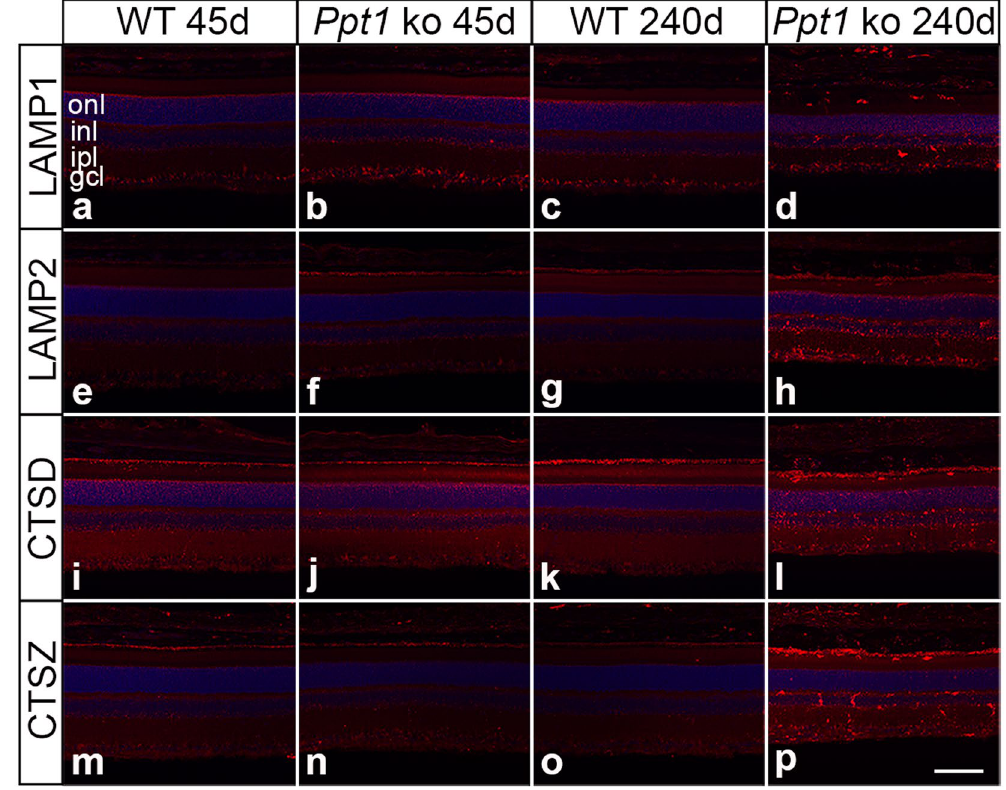
Figure 4. Dysregulation of lysosomal proteins in PPT1-deficient retinas. Expression levels of LAMP1, LAMP2, CTSD and CTSZ were slightly elevated in 45-day-old mutant animals ( b,f,j,n , respectively) when compared to age-matched wild-type mice ( a,e,i,m , respectively). Pronounced upregulation of LAMP1-, LAMP2-, CTSD- and CTSZ-immunoreactivity was observed in 240-day-old Ppt1 ko retinas ( d,h,l,p , respectively). The corresponding immunostainings of P240 control retinas are shown in ( c,g,k,o ), respectively. gcl: ganglion cell layer; inl: inner nuclear layer; ipl: inner plexiform layer; onl: outer nuclear layer. Scale bar in ( p ) for ( a–p ): 100 µ